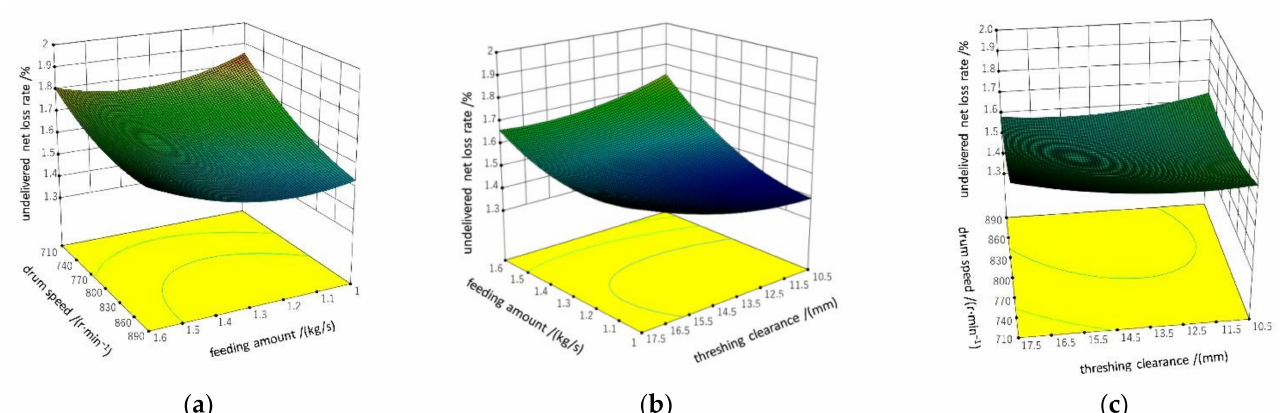
Figure 12. Influence of drum speed, feeding amount, and threshing clearance on undelivered net loss rate. ( a ) the picture shows the influence of drum speed and feeding amount on undelivered net loss rate; ( b ) the picture shows the effect of threshing clearance and feeding amount on undelivered net loss rate; ( c ) the picture shows the effect of threshing clearance and drum speed on undelivered net loss